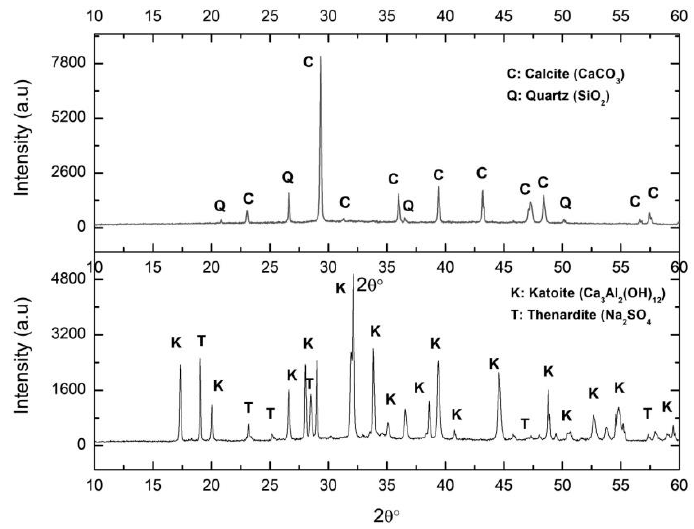
Figure 4. XRD of the samples PGAB: calcite (above) and PGAS: katoite precipitate (below). C: Calcite, Q: Quartz, K: Katoite, T: Thenardite.